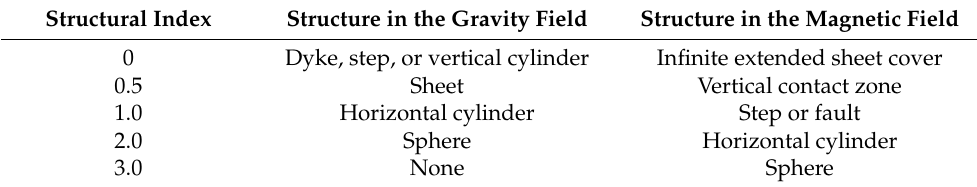
Table 1. Geological bodies corresponding to different structural indexes. Structural